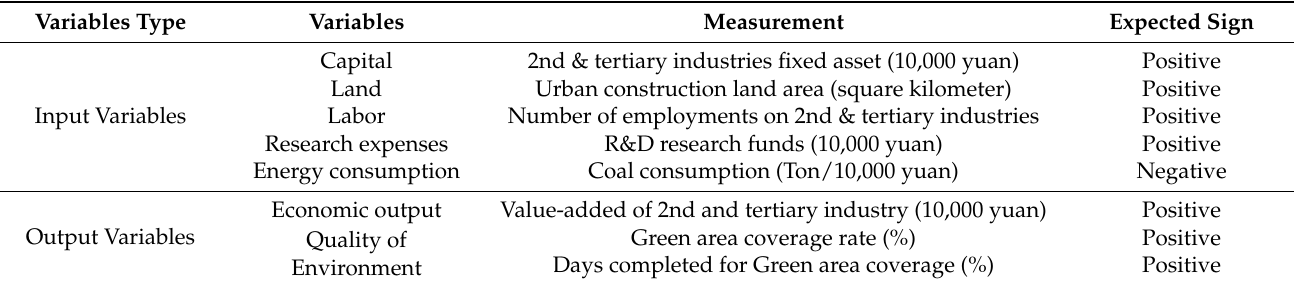
Table 1. Variables of land use efficiency